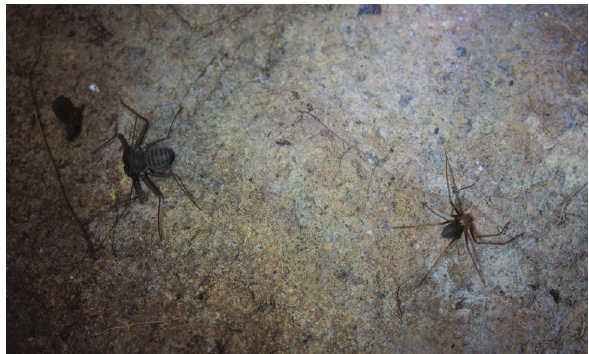
Figure 3. The whip spider Charinus asturius (left side, carapace length ~ 4 mm) and a recluse spider Loxosceles sp. (right side) sharing the undersurface of a